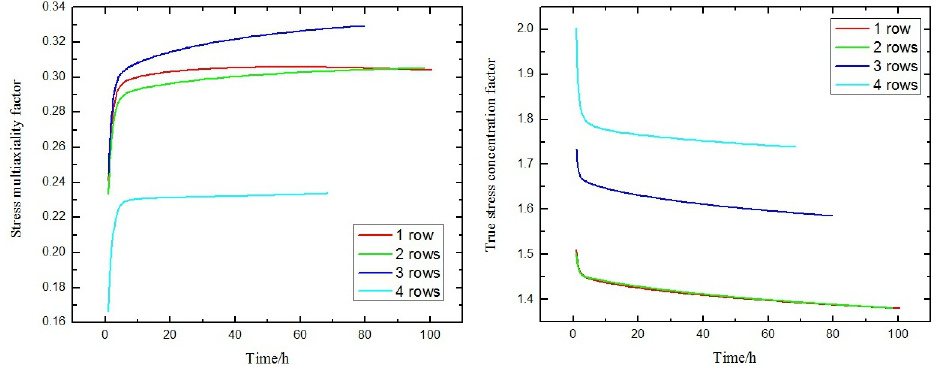
Figure 8. Time dependence of stress multiaxiality factor λ and true stress concentration factor κ .